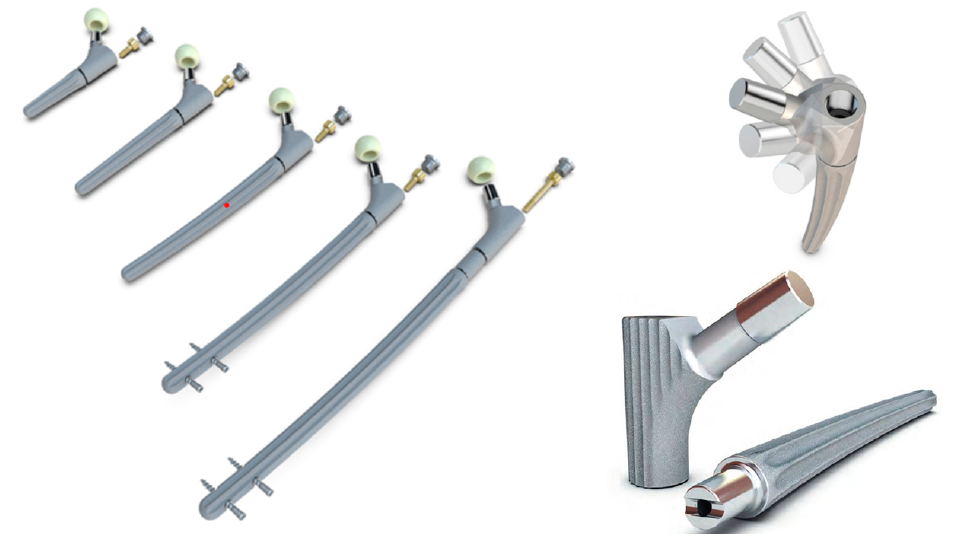
Figure 1. Implant characteristics MRP ® revision stem: straight stems of 80, 140 and 200 mm length are available and curved stems of 200, 260 and 320 mm length. Three neck lengths (50, 60 and 70 mm) and a lengthening piece between distal stem and neck of 30 mm allows a continuous adaptation of the implant length between 130 and 420 mm in 10 mm steps. A diameter beginning from 13 up to 25 mm is available for the 80 mm stem and between 13 to 30 mm for the 140 and 200 mm device. The range of the diameter is from 11 to 29 mm for the 260 and 320 mm option. There are two neck options connectable, a standard offset neck and a lateralized piece with an increased offset of 10 mm.